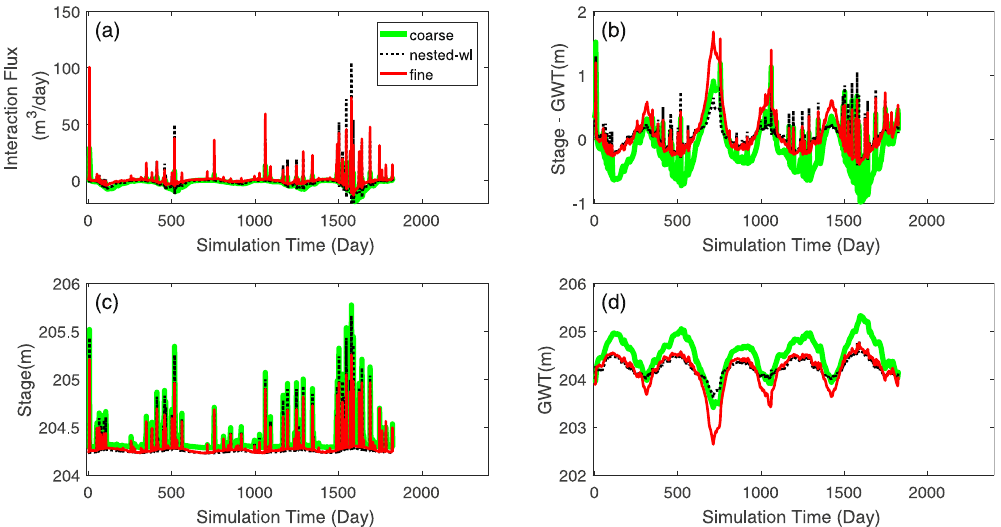
Figure 8. Plots of wetland-stream interaction flux ( a ), difference between river stage and GWT ( b ), river stage ( c ), and GWT time series ( d ). Negative Stage-GWT implies that stage is lower than GWT and wetland discharges into the stream. A positive Stage-GWT implies wetland recharges from